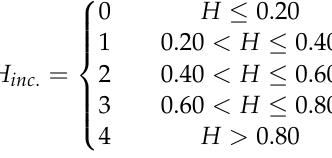
Figure 6. Functional value assignment for the cuttings bed height parameter. The parameter 𝐻 (cid:3036)(cid:3041)(cid:3030). is evaluated for all non-vertical sections, because no cuttings bed will form in the [0, 30) degree inclination interval. Thus, the bed height components of the state vector are { 𝐻 (cid:2871)(cid:2868)(cid:2879)(cid:2872)(cid:2873) , 𝐻 (cid:2872)(cid:2873)(cid:2879)(cid:2874)(cid:2868) , 𝐻 (cid:2874)(cid:2868)(cid:2879)(cid:2875)(cid:2873) , 𝐻 (cid:2875)(cid:2873)(cid:2878) }. ECD As previously discussed, ECD needs to be managed within the drilling margin. There is, however, some degree of uncertainty associated with its limits, which is accounted for by considering an uncertainty factor 𝐷𝐹(cid:4666)≤ 0.25) . ECD (cid:3028)(cid:3049)(cid:3034) , the average ECD for an inclination